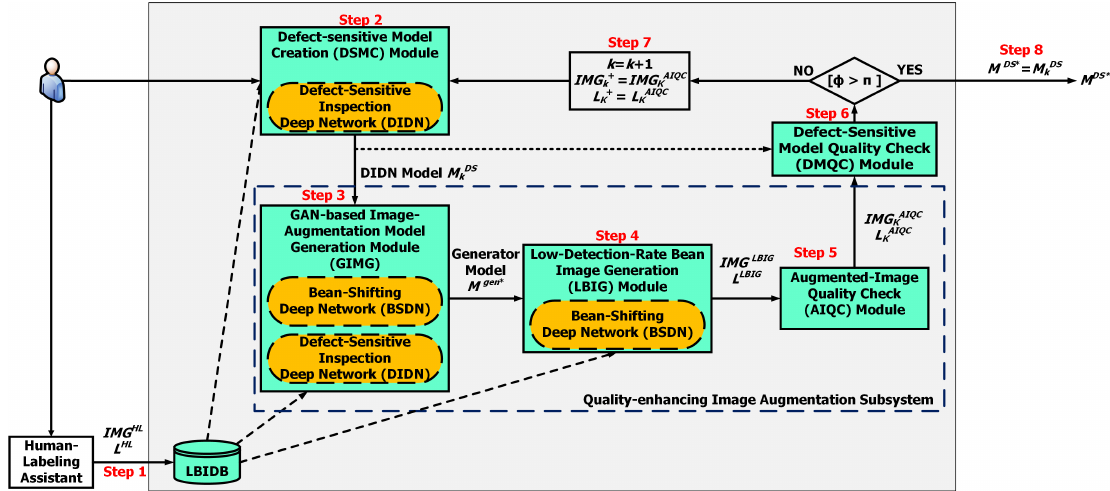
Figure 4. The architecture and workflow of the proposed labor-efficient deep learning-based model generation scheme. The output model M DS ∗ plays the role of the defective bean inspection (DBI) model in Figure 3. LBIDB = labeled-bean image